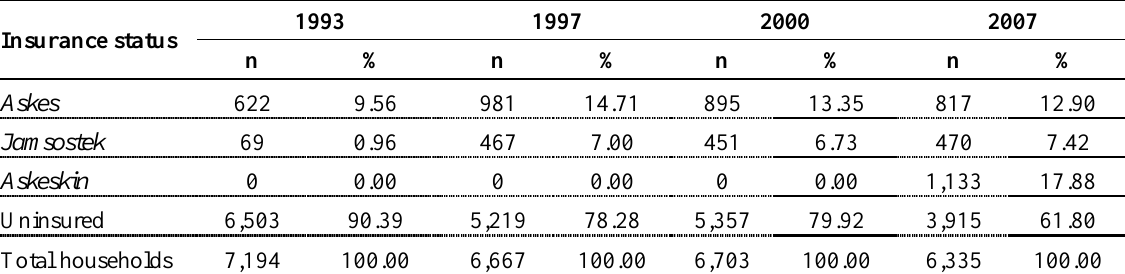
Table 3. The distribution of health insurance status across